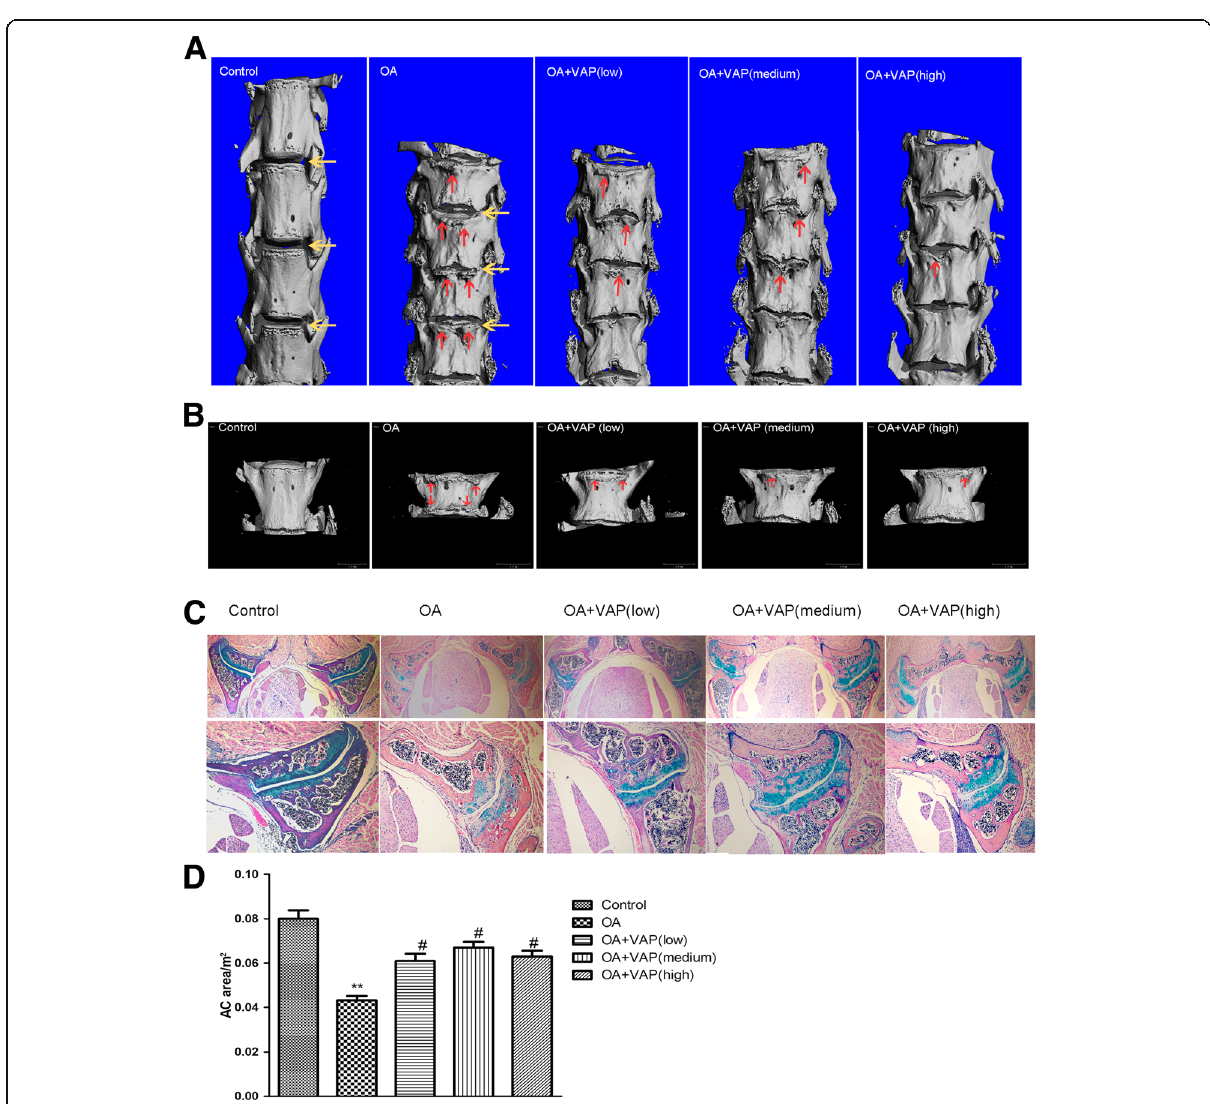
Fig. 1 VAP partially rescue β -catenin(ex3) Col2CreER mice facet joint-like phenotype. OA model group showed osteophytes formation (red arrow) and disc space narrowing (yellow arrow) on L1-L4 ( a ). However, the osteophyte formation around the lumbar intervertebral disc decreased in VAP different dosage groups, especially in 4th lumbar vertebral ( b ). Micro-CT ( μ CT) data show VAP partially rescue β -catenin(ex3) Col2CreER mice lumbar disc osteophyte formation. Histologic results demonstrated that facet joint phenotype of the WT group is normomorph, the articular cartilage surface is smooth and complete, cartilage layer is clear, chondrocyte under the articular cartilage arranged orderly. Histology of model group displayed severe loss of facet joint cartilage tissue compare with wild type group, part of the cartilage surface appear damage, cartilage layer dye and thinning. After treat with VAP, the number of facet joint growth plate chondrocytes increase. Representative photos show the morphology using microscopy ( c ). Histomorphometry analyze the articular cartilage area of each histology section. Alcian blue-stained areas were outlined on projected images to determine facet joint ’ s articular cartilage area. * P < 0.05,** P < 0.01 vs Control group; # P < 0.05, ## P < 0.01 vs OA group. Data were expressed as mean ± SD. The results indicate VAP may increase FJ articular cartilage area ( d